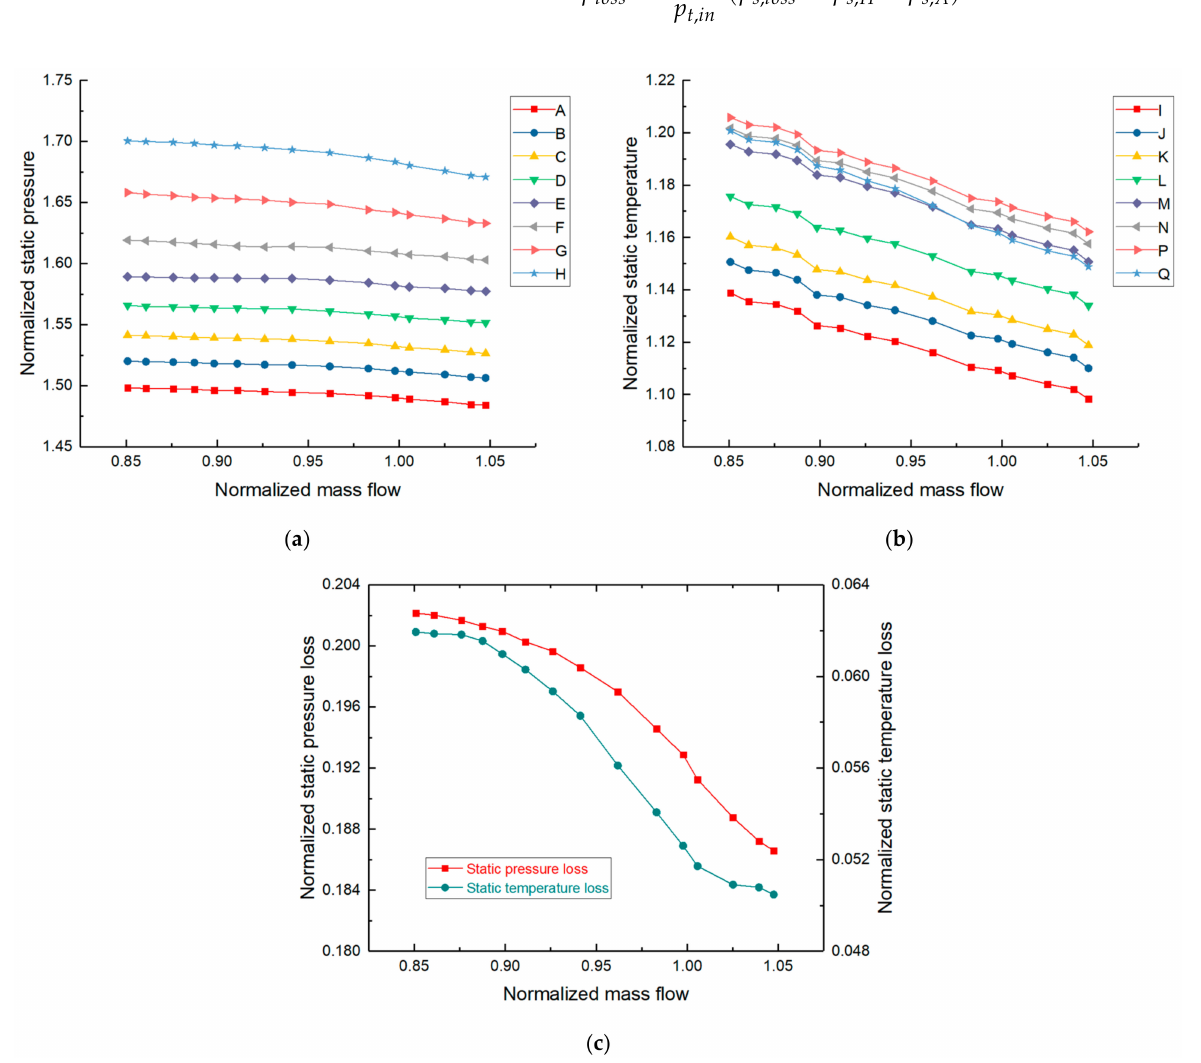
Figure 7. Characteristic curves of aerodynamic parameters and respective loss on the static wall of IBC: ( a ) static pressure; ( b ) static temperature; ( c ) static pressure loss and static temperature